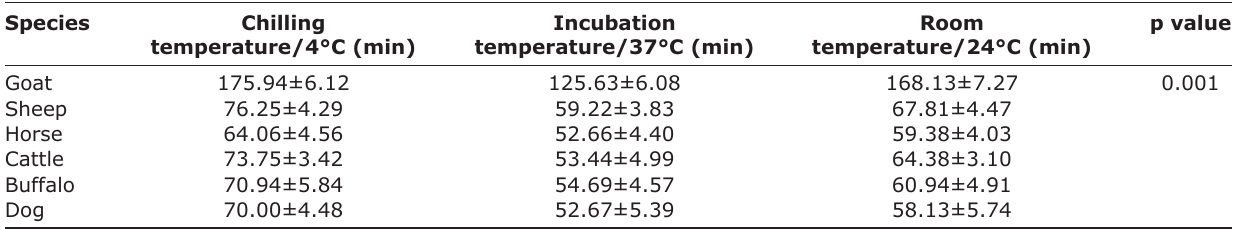
Table-4: Time required for HA of mammalian RBC with VVNDV (field strain) within different temperatures (mean±SD). Species Goat